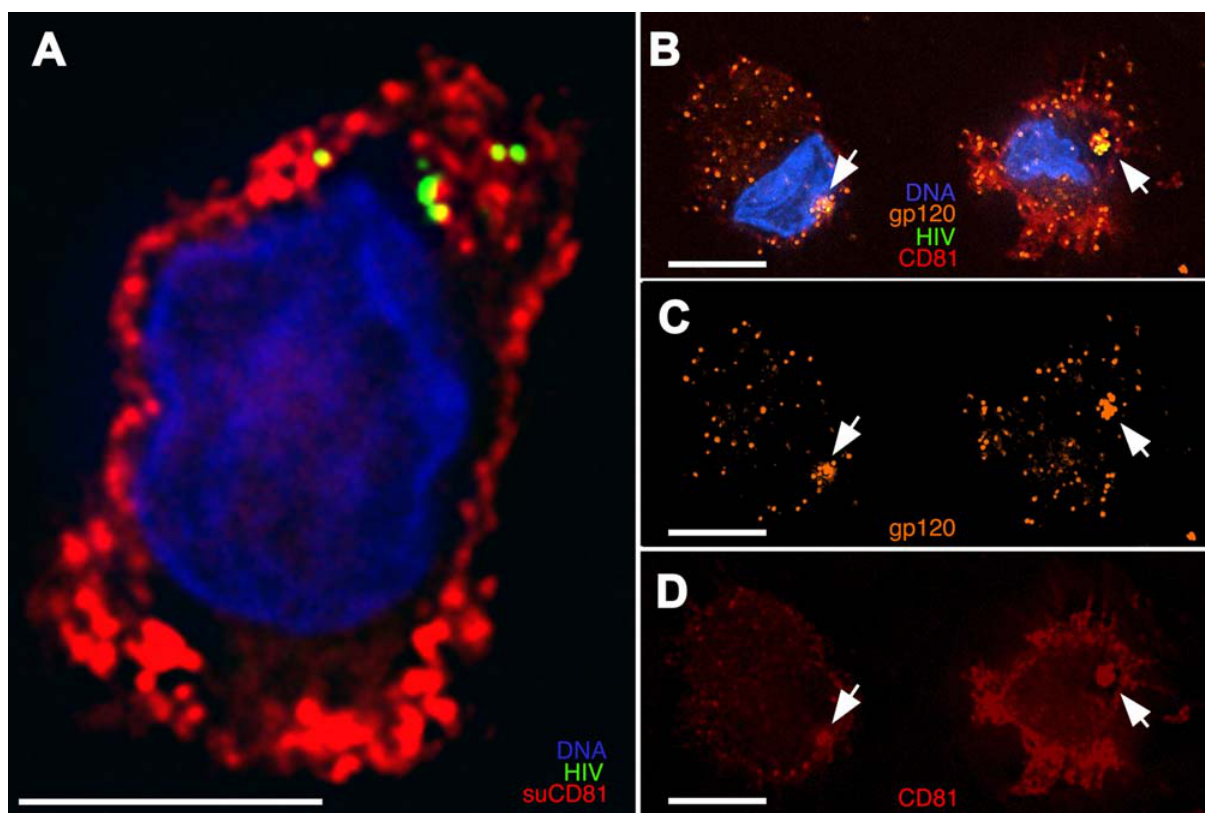
Figure 8. Compartmentalized HIV remains accessible to surface probes after extended culture. (A) Mature MDDCs were exposed to HxB2 pseudotyped GFP-HIV for 1 h, washed, and cultured at 37 u C for 24 h. Cells were then incubated at 4 u C with a mouse anti-CD81 mAb, washed, fixed onto coverslips, and stained with an anti-mouse antibody (red). Image is a single z-plane demonstrating concentrated HIV associated with the surface-accessible compartment. See also Video S5 for the entire z-stack compiled as a movie. (B–D) DCs prepared as in (A) were incubated at 4 u C with 2G12 anti-HIV Env (gp120) mAb, washed, fixed, and immunostained for 2G12 (gp120) (orange) and CD81 (red). Images are 3-D–rendered whole- cell volumes; arrows denote compartmentalized HIV. Bars, 5 m .